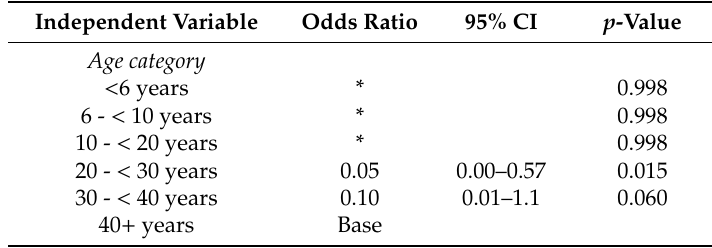
Figure 1. Histogram of radiographic outcomes by age category. Table 8. Multivariable logistic regression results for variables associated with significant radiographic findings for gibbons undergoing elective health checks between 2011 and 2018.